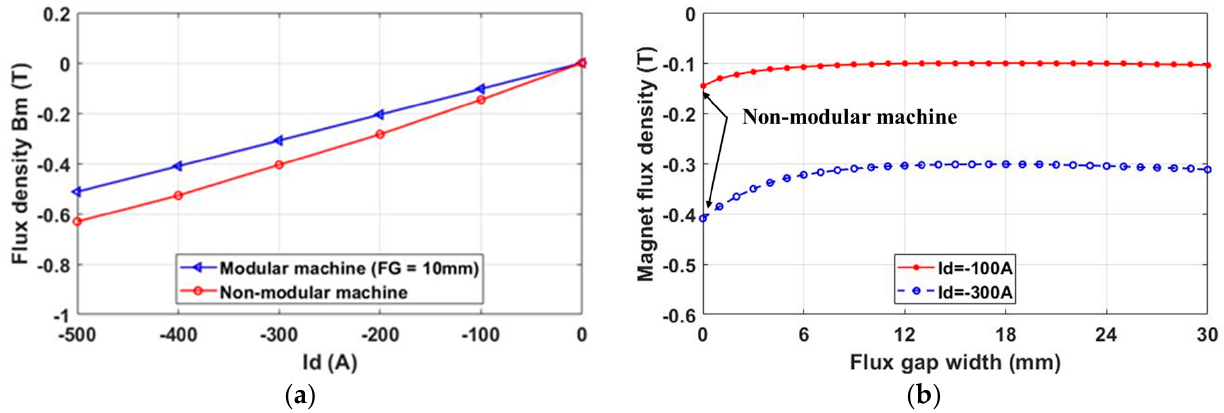
Figure 12. The minimum magnet flux density at point A generated by applied 3-phase armature currents at 20 °C. ( a ) B m vs. current amplitude, and ( b ) B m vs. FG width for I d = − 100 A and − 300 A.